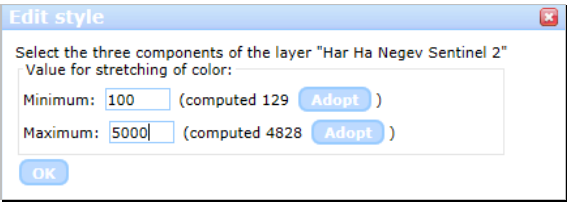
Figure 1. HTML representation of a JavaScript generated window to define the maximum value and the minimum value to stretch the colour map in an image with continuous values. The second mode requires that 3 bands are requested to the server. The first returned binary array will be rescaled to represent the R colour channel intensity between 0 and 255 of all pixels of the screen; the second will be rescaled to represent the G colour channel and the third to represent the B colour channel. The individual bands can be obtained from 3 different layers of a WMS server or from the same layer but with an extra dimension parameter to extract individual bands (e.g. DIM-BAND=4). This mode is useful to represent band combinations (e.g. obtaining a natural colour image from a Sentinel 2 image by requesting the bands 4, 3, 2 from the RGB values) (see Figure 2 and Figure 4).